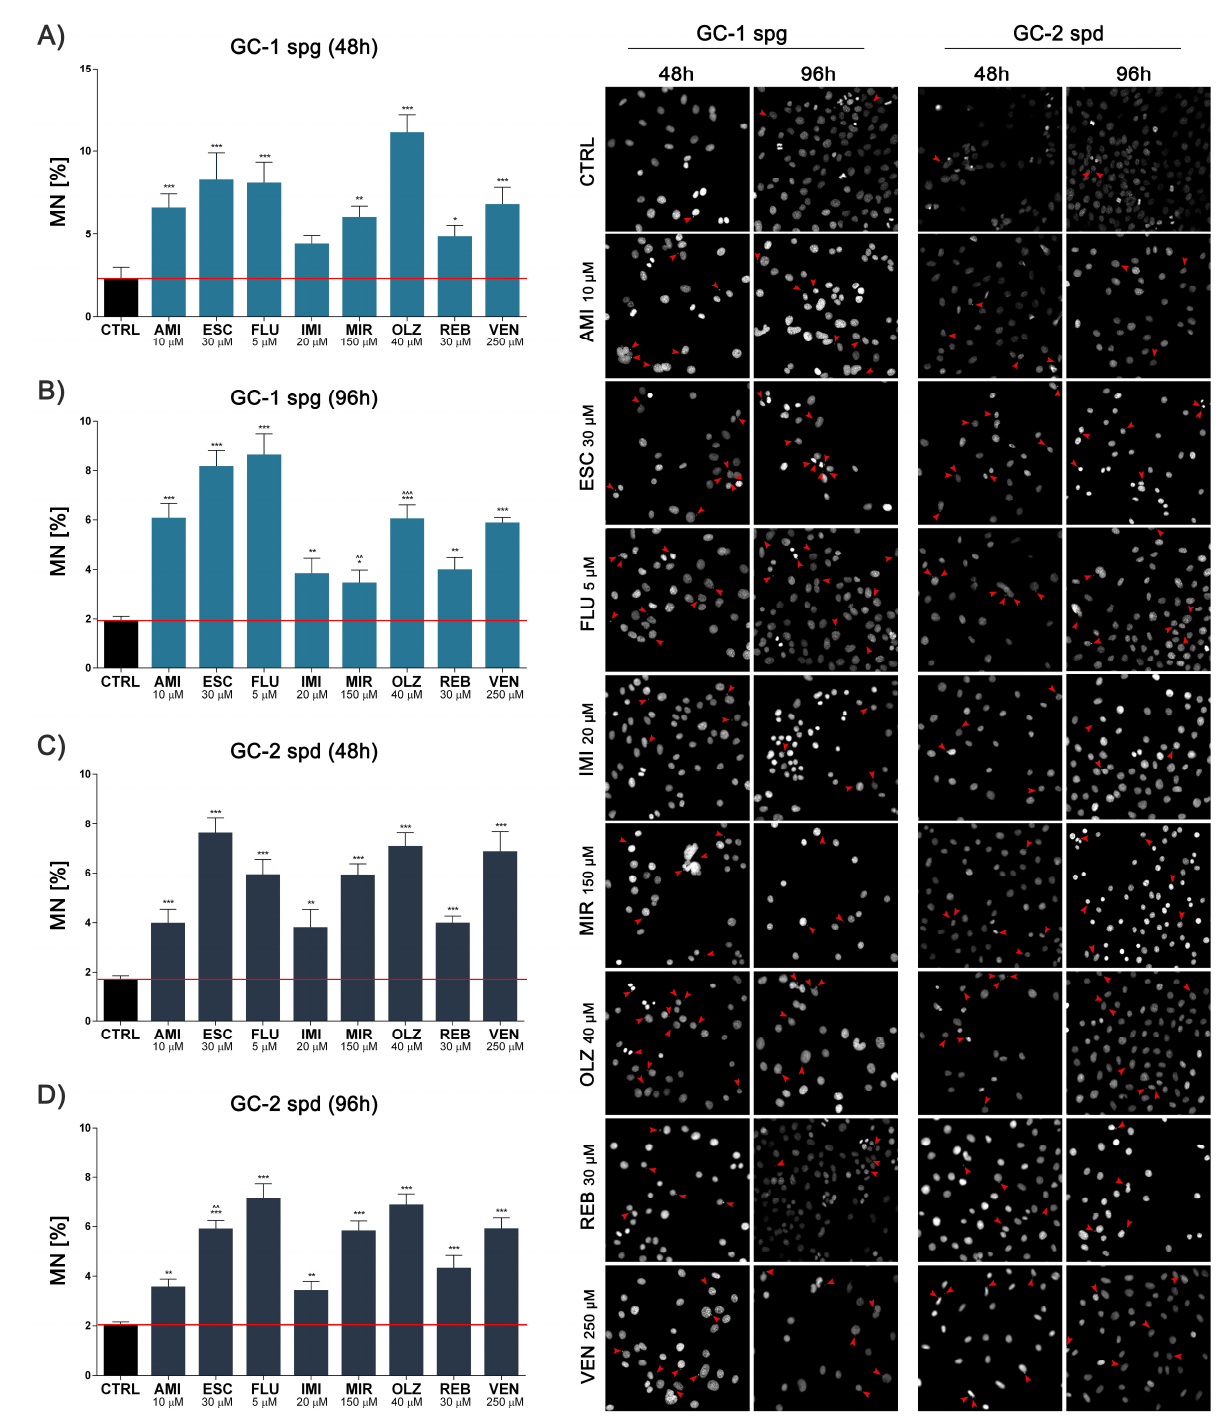
Figure 4. Antidepressants increase the frequency of micronuclei formation. Mouse spermatogenic cells were treated for 48 and 96 h and then the effects of antidepressants on micronuclei formation (MN) were evaluated ( A – D ). Representative photos are shown; red arrows indicate MN (magnification 10×). Statistical differences were determined using one-way analysis of variance (ANOVA) with Dunnett’s post-hoc test; p values < 0.05 were considered statistically significant. Asterisks (*) indicate the comparison between control and antidepressants-treated cells, whereas carets (^) indicate the comparison between the same drugs in different periods (48 vs. 96). Bars indicate mean ± SD, n = 3, ***/^^^ p < 0.001, **/^^ p < 0.01, * p < 0.05, no indication–no statistical significance.